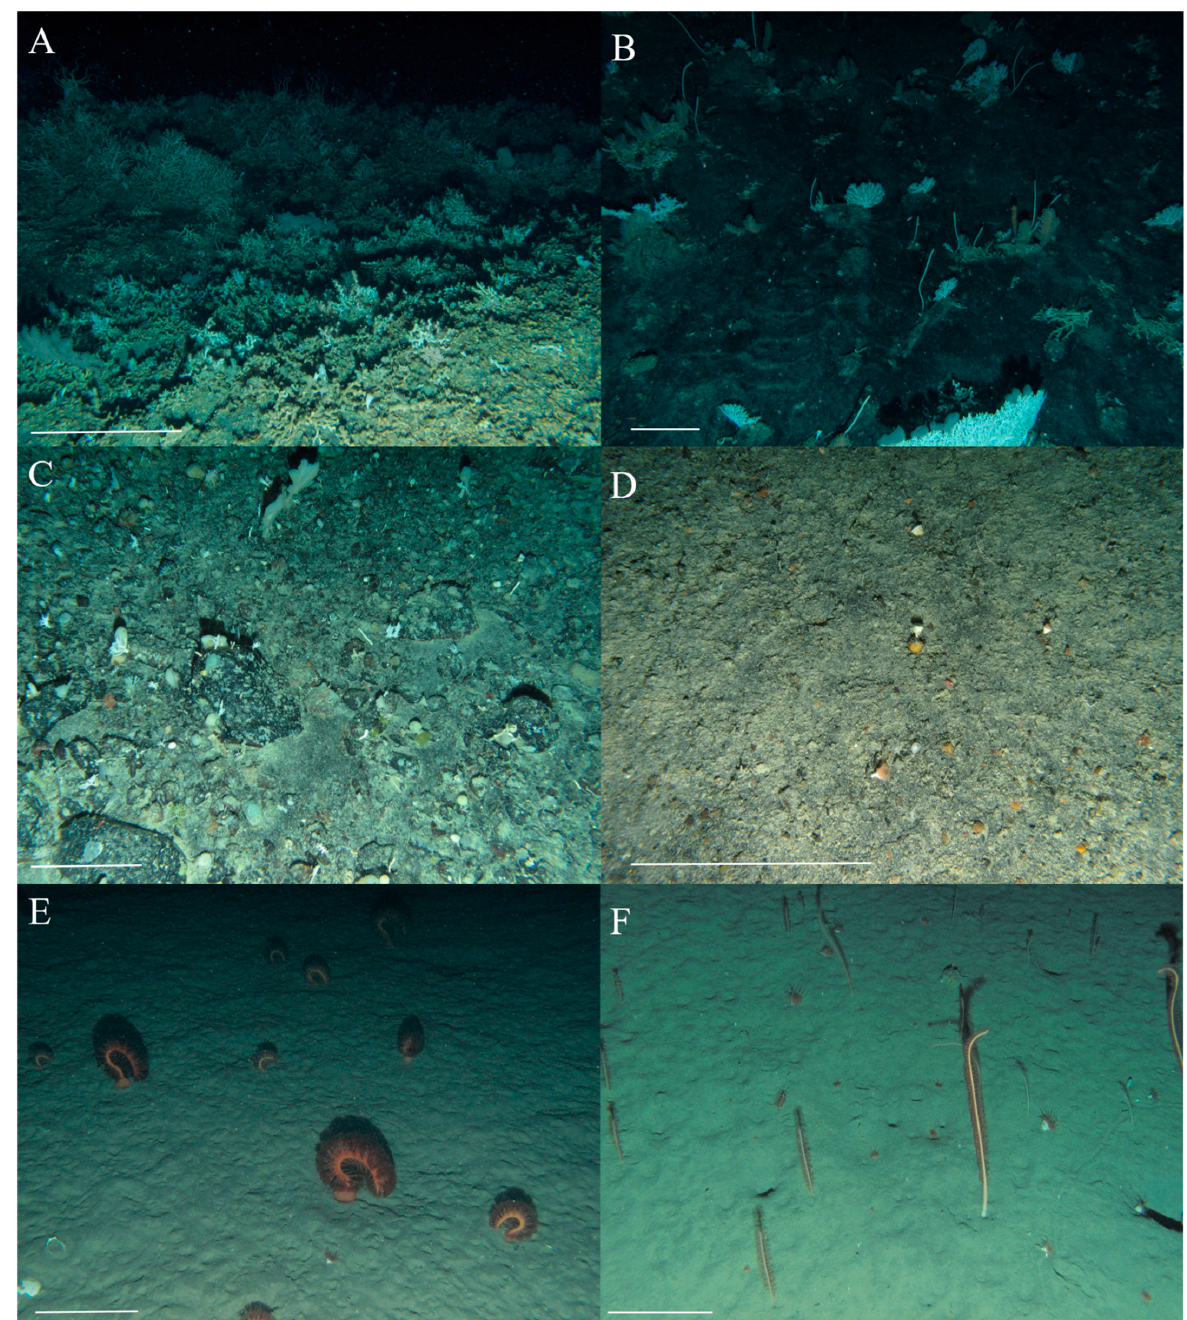
Figure 2. Example images of fauna and substrata. ( A ) Bathelia candida reef observed at 1280 m water depth. ( B ) Mixed cold-water corals, including Stylaster densicaulis and Primnoidae, Stylasteridae, and Porifera morphospecies observed at 1280 m water depth. ( C ) Stylasteridae and Massive Ball Porifera morphospecies were observed from mixed substratum at 1595 m water depth. ( D ) Solitary cup corals, including Flabellum sp. and Scleractinia sp. 5, were observed from coarse substratum at 1406 m water depth. ( E ) Anthoptilum grandiflorum and Flabellum sp. observed from sandy mud at 1225 m water depth. ( F ) Pennatulacea sp. and Flabellum sp. observed from sandy mud at 1330 m water depth. Scale bar = 30